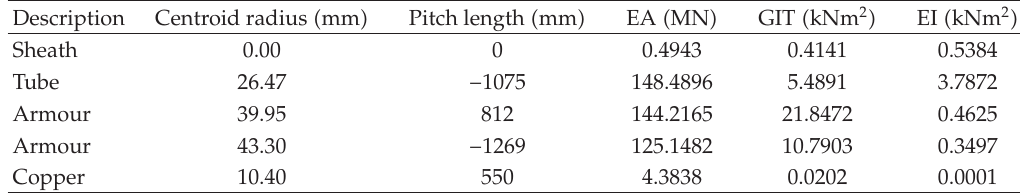
Table 9: Umbilical 6 parameters.